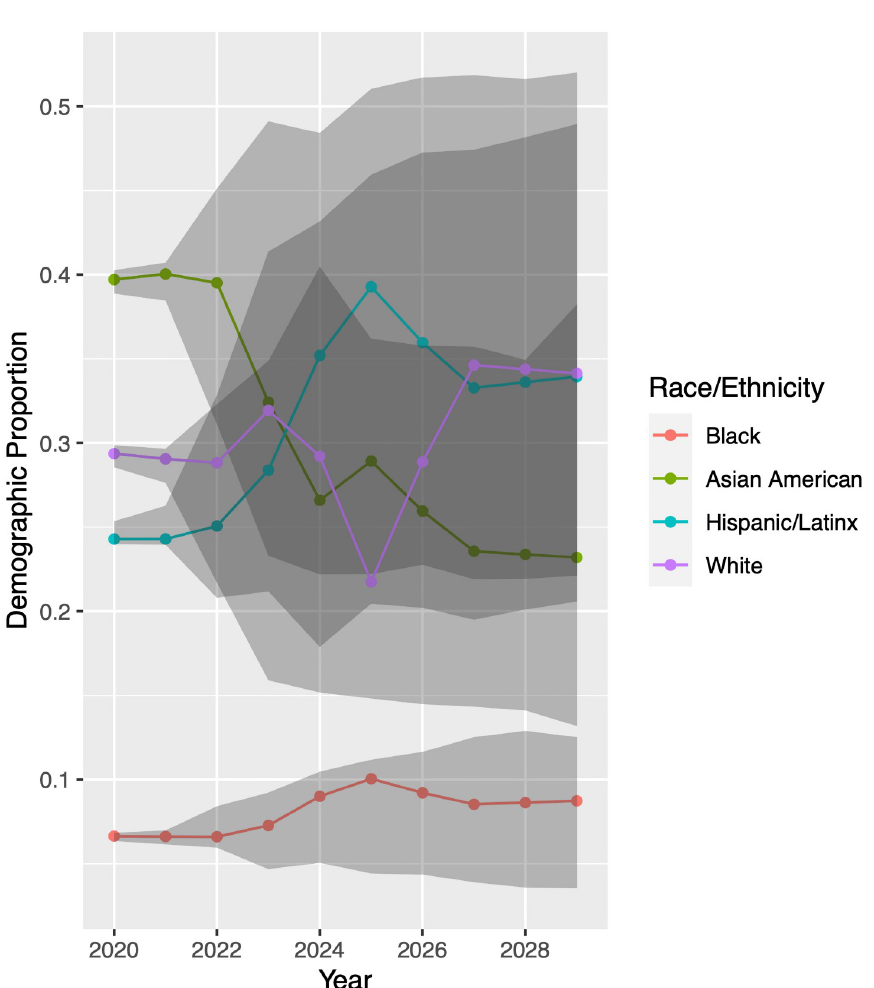
Fig 8. Model predictions for University of California-Los Angeles. While the uncertainty in prediction is large after two years due to the difficulty in extrapolating model input parameters, it is clear that the proportion of Black students will remain quite low. Colored dots are model output obtained when using the parameters forecast in Inferring Model Parameters. We perform an additional 2800 model simulations using parameter sets generated by Latin hypercube sampling. Grey bands indicate the central 95% of these results. Demographic proportions are relative to each other; see Mathematical